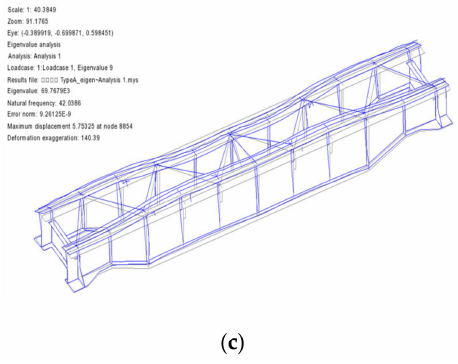
Figure 9. Analysis of natural frequencies of track girders by mode. ( a ) 1st bending mode (25.94 Hz); ( b ) 1st torsional mode (33.68 Hz); ( c ) 2nd torsional mode (42.04 Hz).